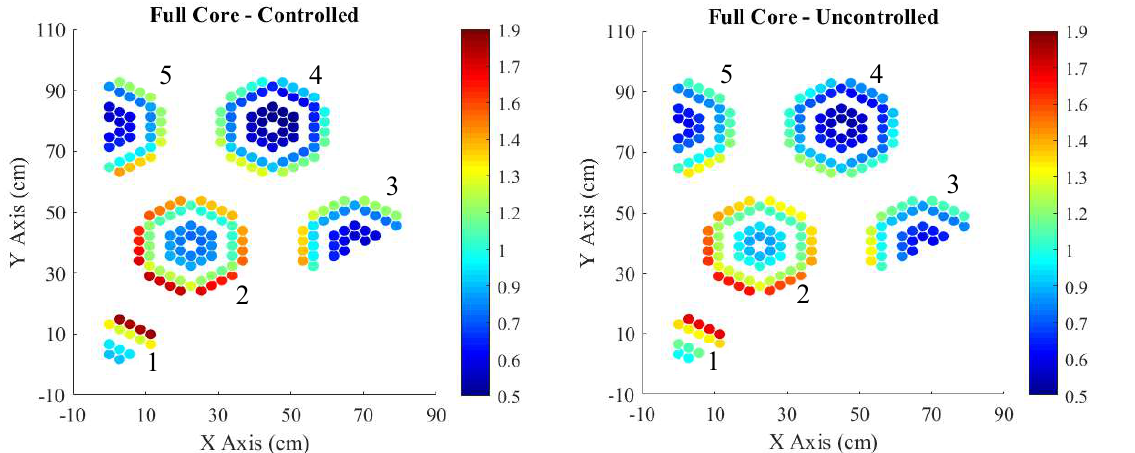
Figure 5. Relative Pin Fission Density Distribution in Full Core Controlled and Uncontrolled Cases